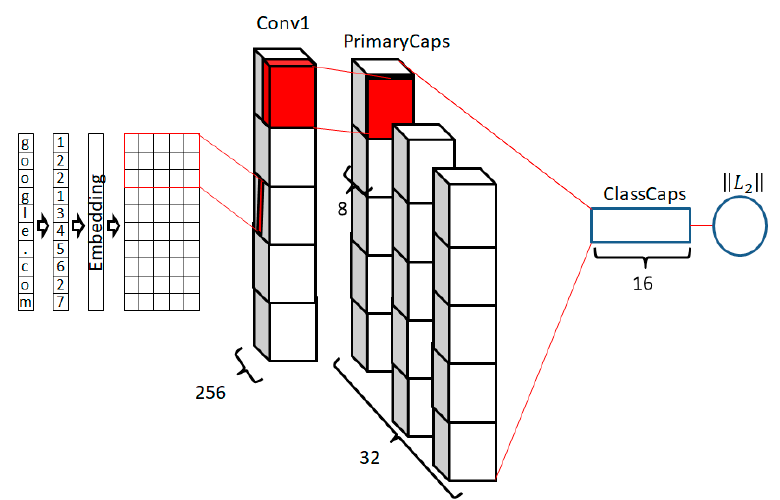
Figure 2. A one-dimensional (1D) capsule network architecture.